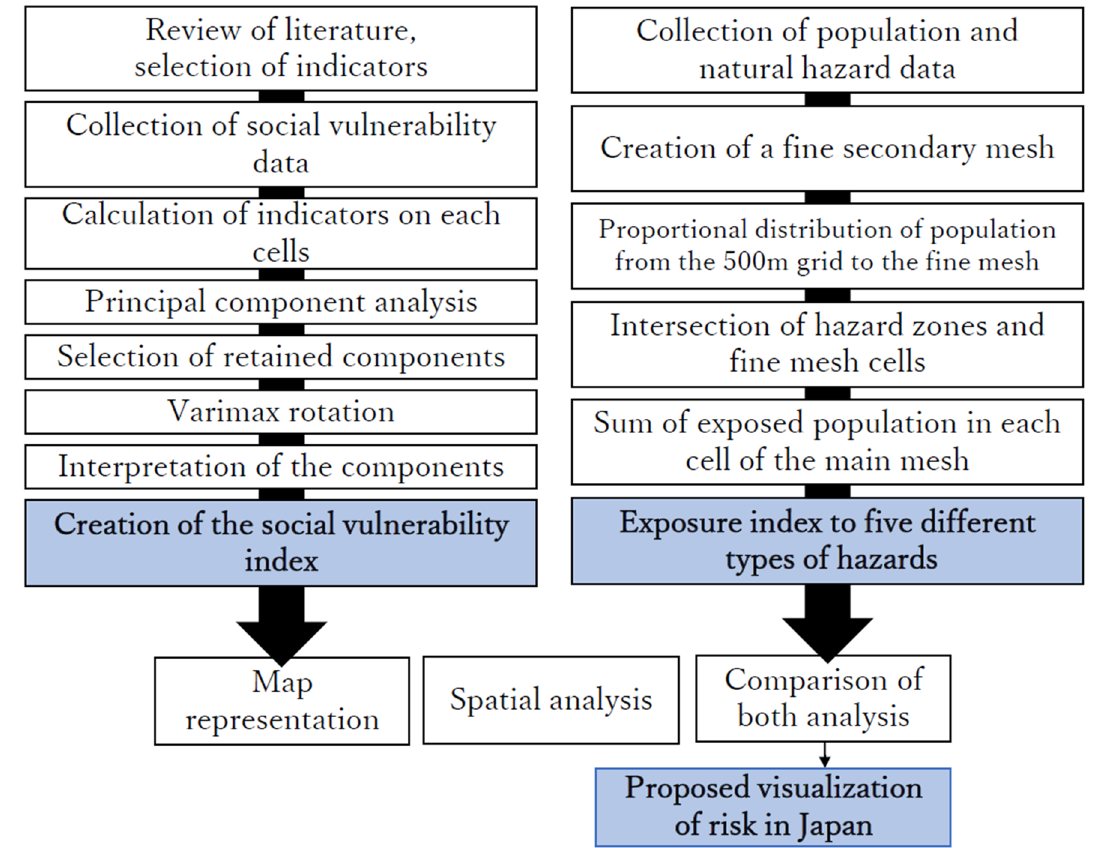
Figure 1. Analytical framework of this study. Data treatments, principal component analysis, Varimax rotation and exposure analysis are detailed in this “Methods” section.